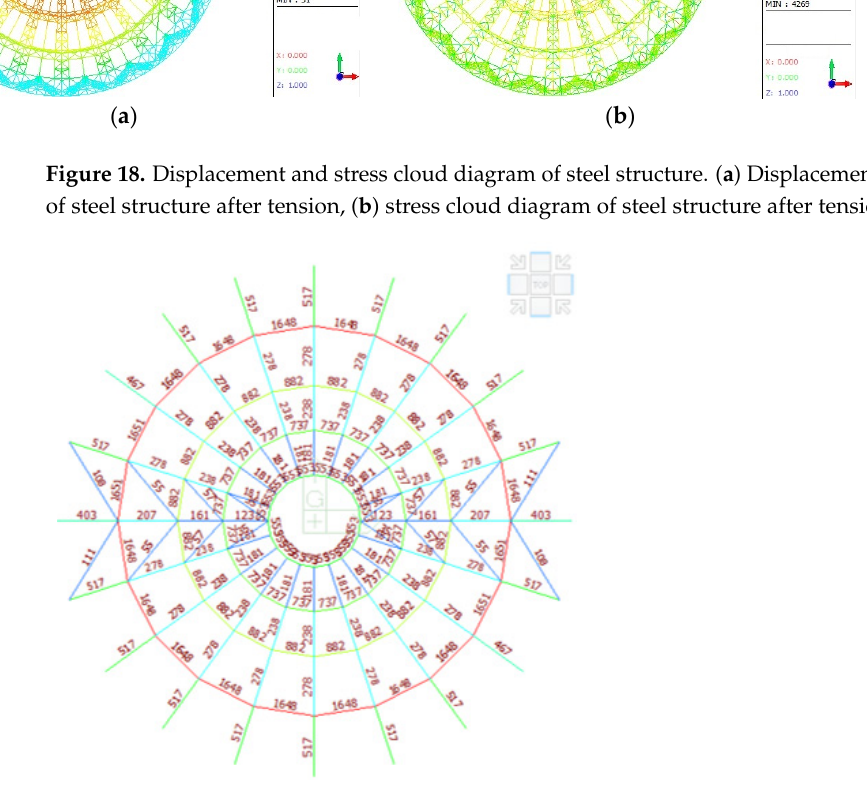
Figure 20. Vertical displacement of prestressed tensioning control nodes. Figures 18 and 19 show that: 1.